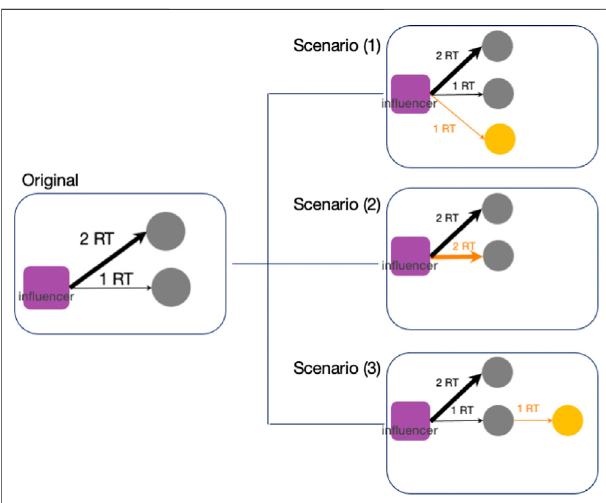
FIGURE 6 | Schematic diagram of our hypothetical scenarios. Orange nodes and arrows are the hypothetical setup parts. In Scenario (1), we add new nodes to retweet in fl uencers directly; in Scenario (2), we increase the number of RTs for nodes that have already retweeted; and in Scenario (3), we added new nodes to retweet nodes which have already retweeted the in fl